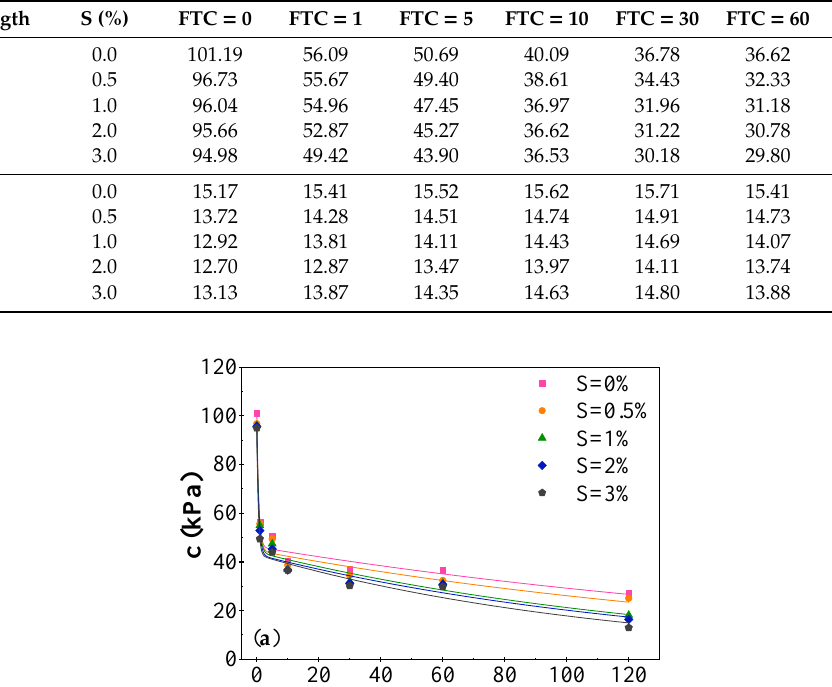
Table 5. Parameters of exponential and Fourier functions that can reflect relationship between c, φ, Table 4. Sample cohesion c and friction angle ϕ .